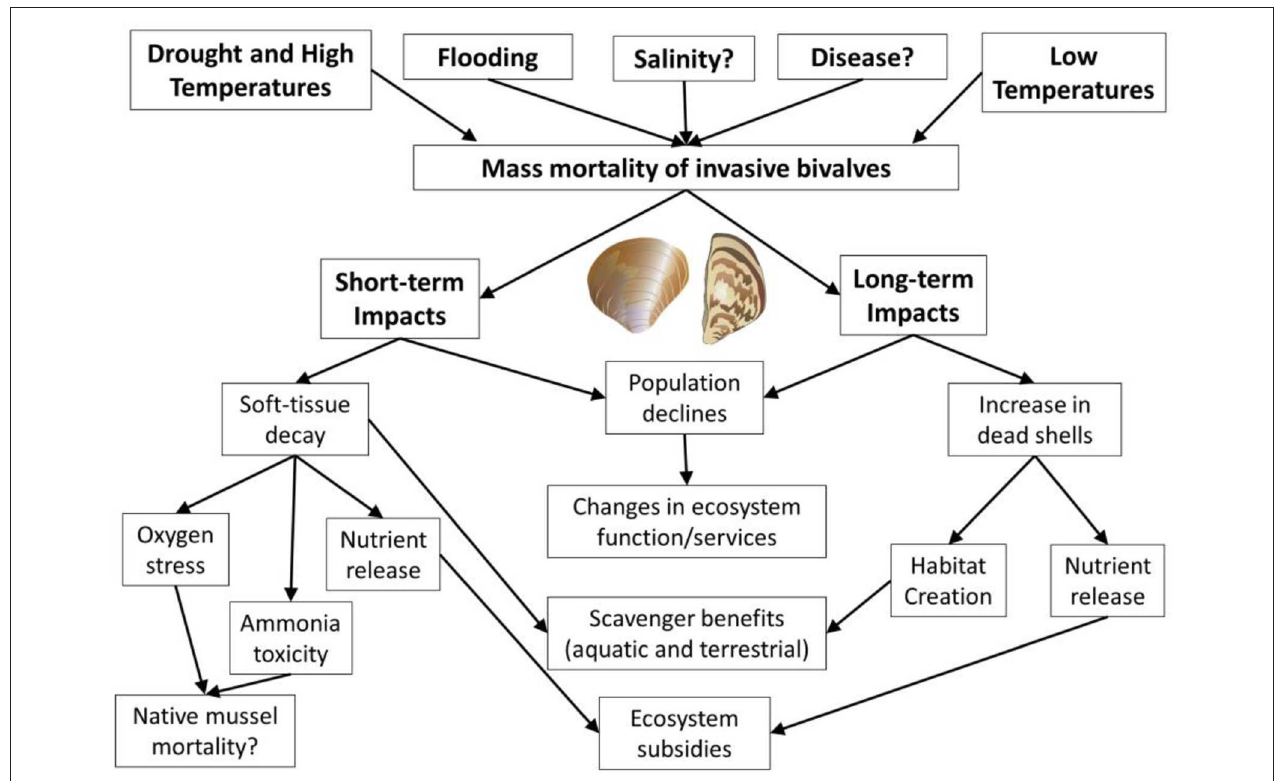
FIGURE 1 | Conceptual diagram of the causes of mass mortality events of invasive bivalves, as well as their short- and long-term impacts. Disease and salinity are included as potential causes of mass mortality events, but have not been documented. Repeated mass morality events could drive down population sizes, particularly if their magnitude or frequency increases due to climate change, though mass mortality events driving long term population declines is hypothetical. Images of Corbicula and zebra mussels are courtesy of the IAN Symbol Libraries